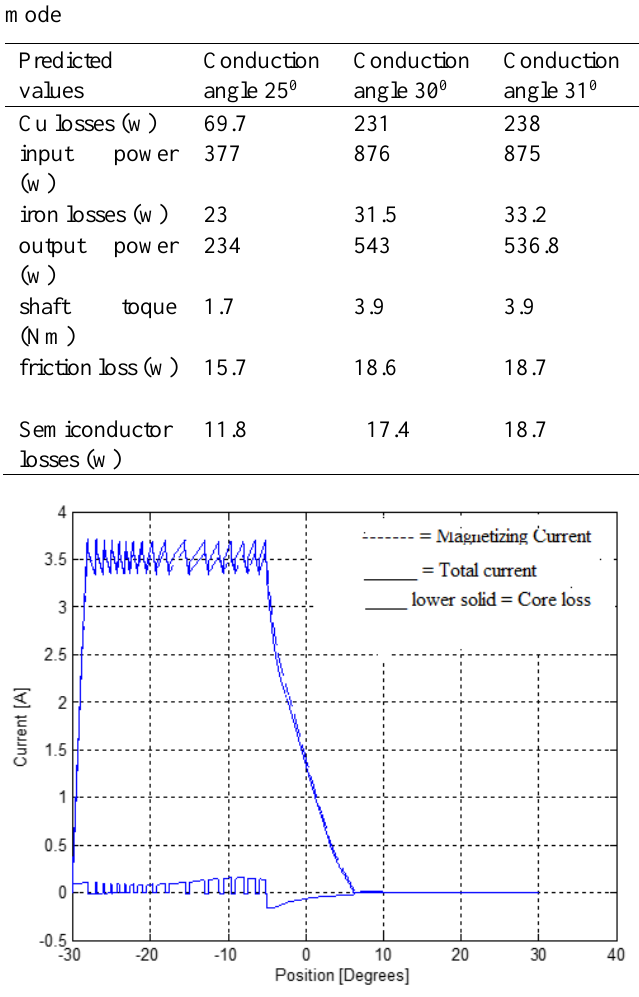
Fig. 13. Representation of current waveforms at conduction angle of 25 0 in current-chopping mode